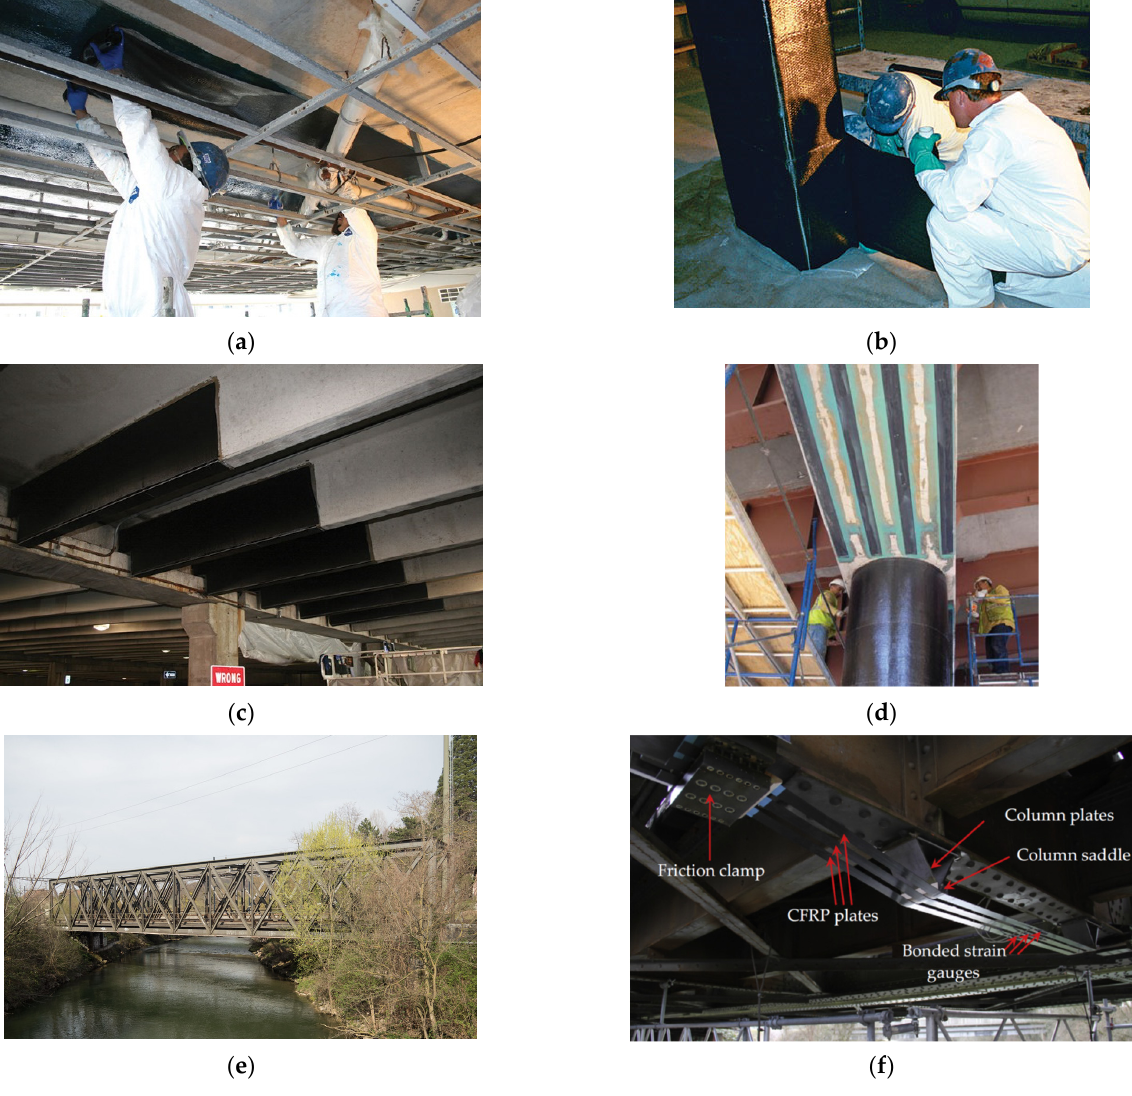
Figure 6. FRP in strengthening applications: ( a ) Flexural strengthening of slab [68]; ( b ) Wrapping FRP fabrics around concrete columns [68]; ( c ) CFRP strengthening of beams [68]; ( d ) FRP plates bonded to beams [66]; ( e ) Münchenstein Railway Bridge (120 years old) Switzerland [69]; ( f ) CFRP strengthening of Münchenstein bridge with sensors to monitor long-term prestress level [69].